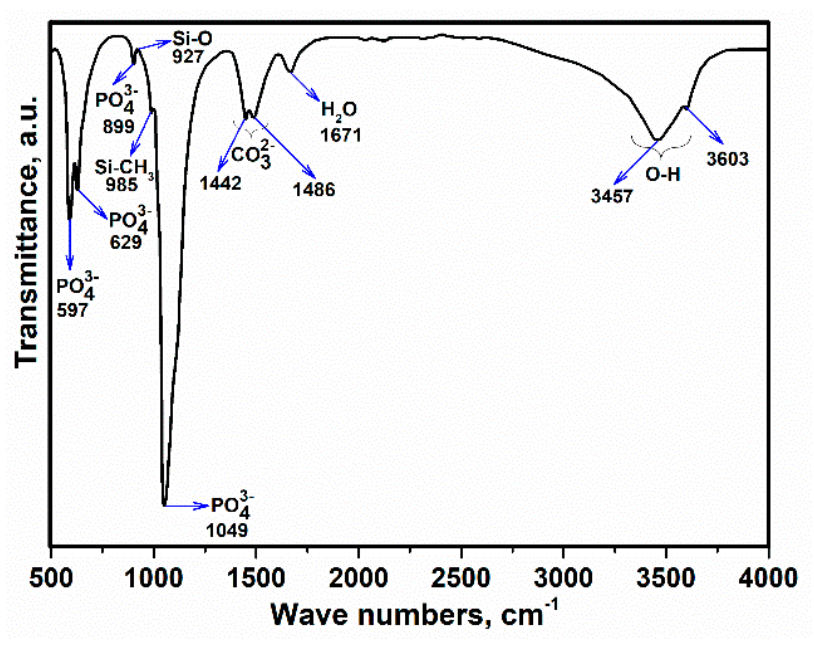
Figure 8. FTIR spectra of Ag-doped HA + PVTMS scaffold.